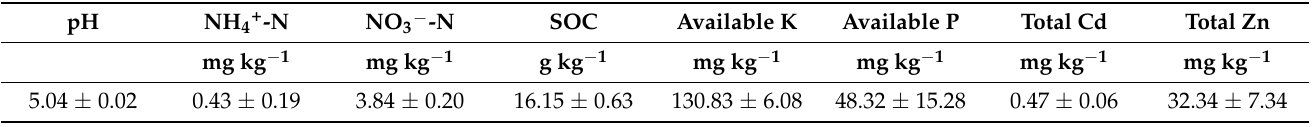
Table 1. Physicochemical properties of the soil in the field. Available K Available P Total Cd Total